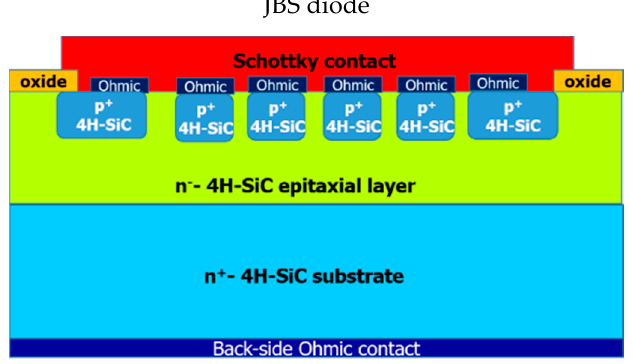
Figure 7. Schematic cross-section view of a 4H-SiC junction barrier Schottky (JBS) diode.